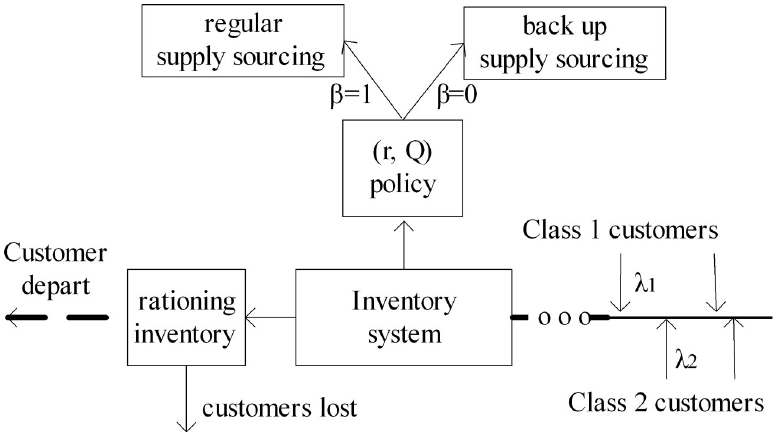
Fig 1. An inventory system replenishing from dual sourcing with two classes of